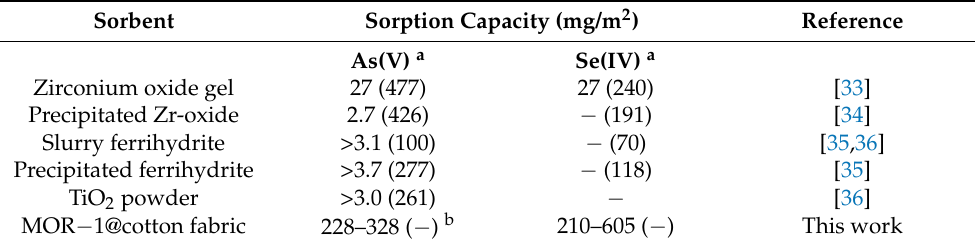
Table 2. Comparison of the sorption capacity of MOR − 1@cotton fabric with other sorbent phases used for the passive sampling of As and Se oxyanions in